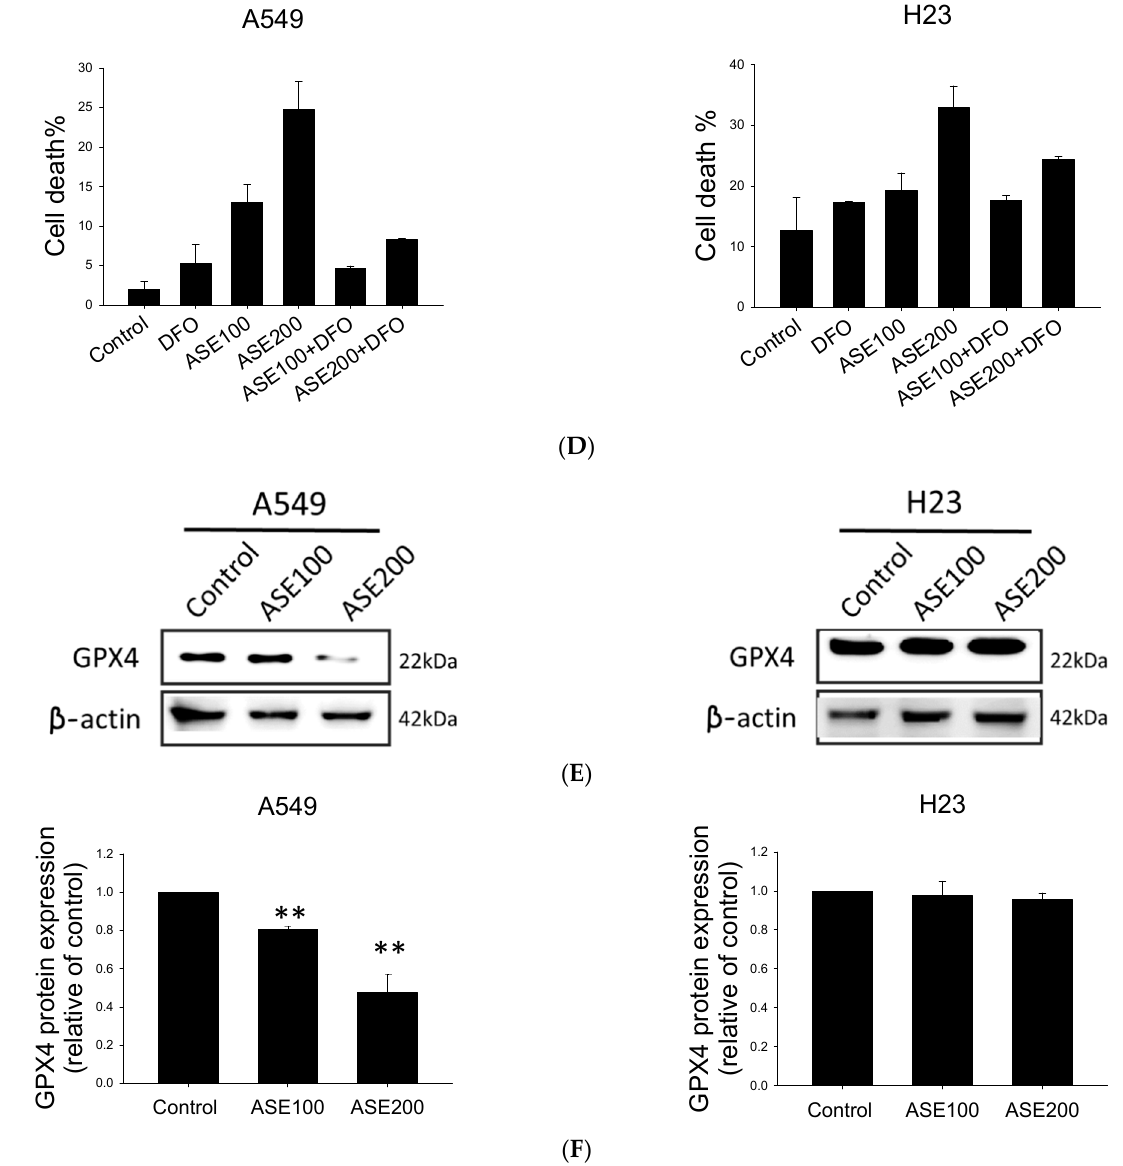
Figure 3. Treatment with the iron chelator, desferrioxamine (DFO), prevented ferroptosis upon response to exposure to the ethanol extract of Artemisia santolinifolia (ASE) in non-small cell lung cancer (NSCLC) cells. A549 and H23 cells were treated with DFO (100 µ M) 12 h prior to ASE (100 and 200 µ g/mL) treatment. ( A ) The ASE induced reactive oxygen species (ROS) production in A549 and H23 cells as determined by a DCFH-DA assay. ( B ) Histograms represent the effect of DFO on ASE-induced ROS production of three replicates (MFI,mean fluorescence intensity), and lipid ROS levels were measured using a C11-BODIPY assay after indicated treatment above ( C ). ( D ) Cell death populations of A549 and H23 cells following ASE treatment for 24 h in the presence or absence of the iron-chelator, DFO, as quantified by Annexin/7-AAD staining and analyzed using flow cytometry. ( E ) Glutathione peroxidase (GPX4) expression levels in A549 and H23 cells after treatment with the ASE at a concentration of 100 and 200 µ g/mL for 48 h. Representative images of Western blot analysis of proteins with the most significant alterations. β -actin was used as a loading control. ( F ) Histograms of Western blot results of three replicates. Data are the mean ± SE; * p < 0.05, ** p < 0.01, *** p < 0.001 vs. the corresponding